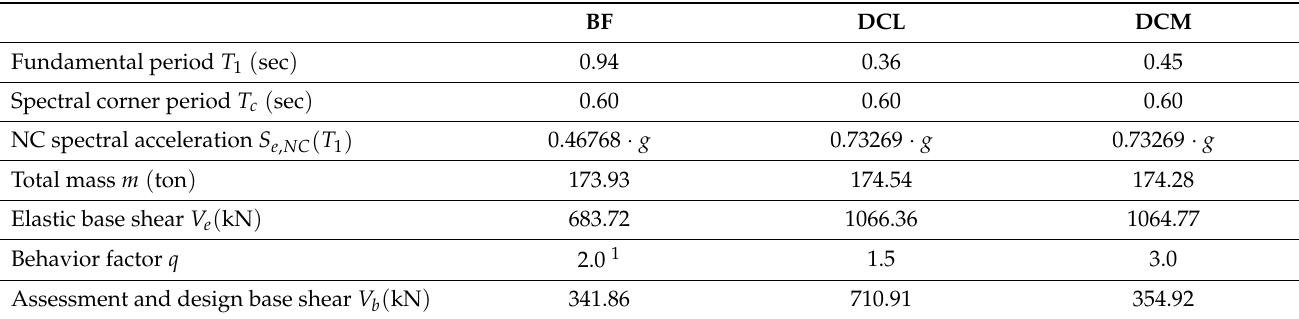
Table 3. Base shear values for the bare (BF) and retrofitted (DCL; DCM)